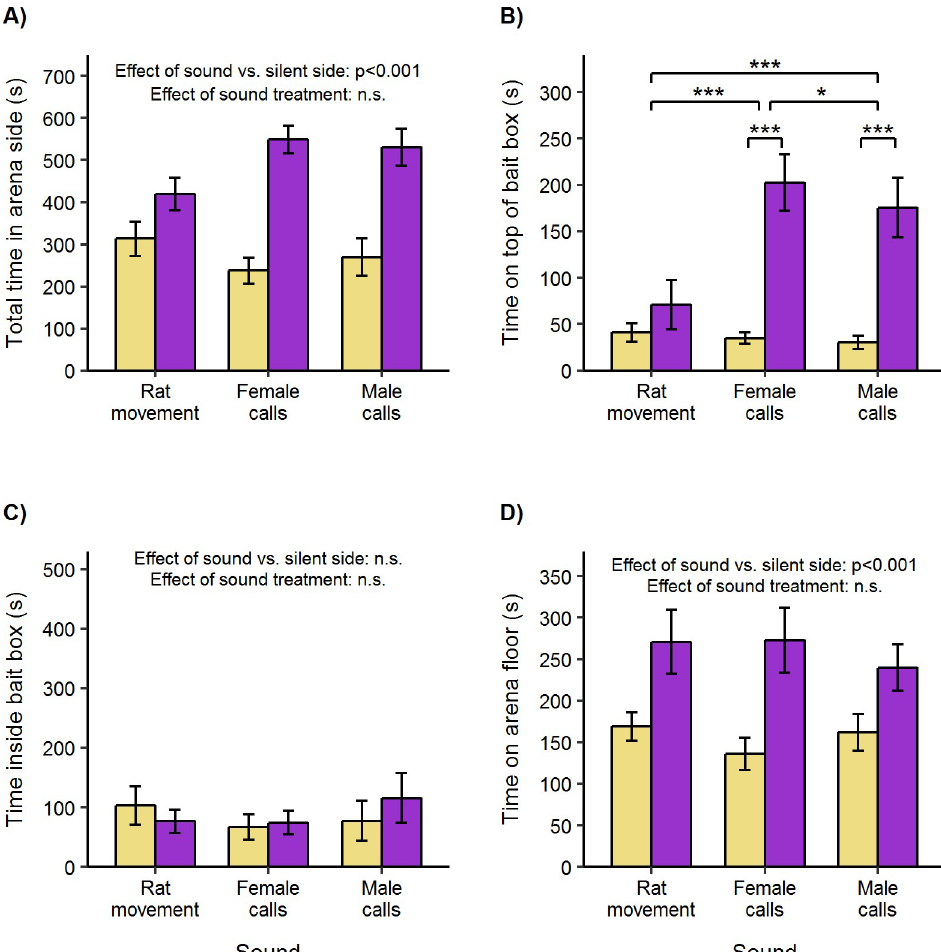
Fig 2. Attraction to rat sounds playing above empty bait boxes (mean ± standard error of mean). Adult male and female Wistar rats were presented with sound playing above an empty bait box (purple bars) versus no sound (yellow bars, control) in opposite side compartments of a test arena. A) Total duration in each side compartment of arena. B) Duration on top of box. C) Duration inside box. D) Duration on arena floor (in arena side but not in or on box). Bias between sides was compared between treatments using repeated measures ANOVA followed by pairwise t-tests (where data approximated normality), or non-parametric two-way ANOVA equivalent followed by Wilcoxon signed-rank tests (where data was not normal). Within each treatment, attraction or avoidance was assessed using one-sample t- tests or Wilcoxon signed-rank tests. ( � p < 0.05, ��� p <